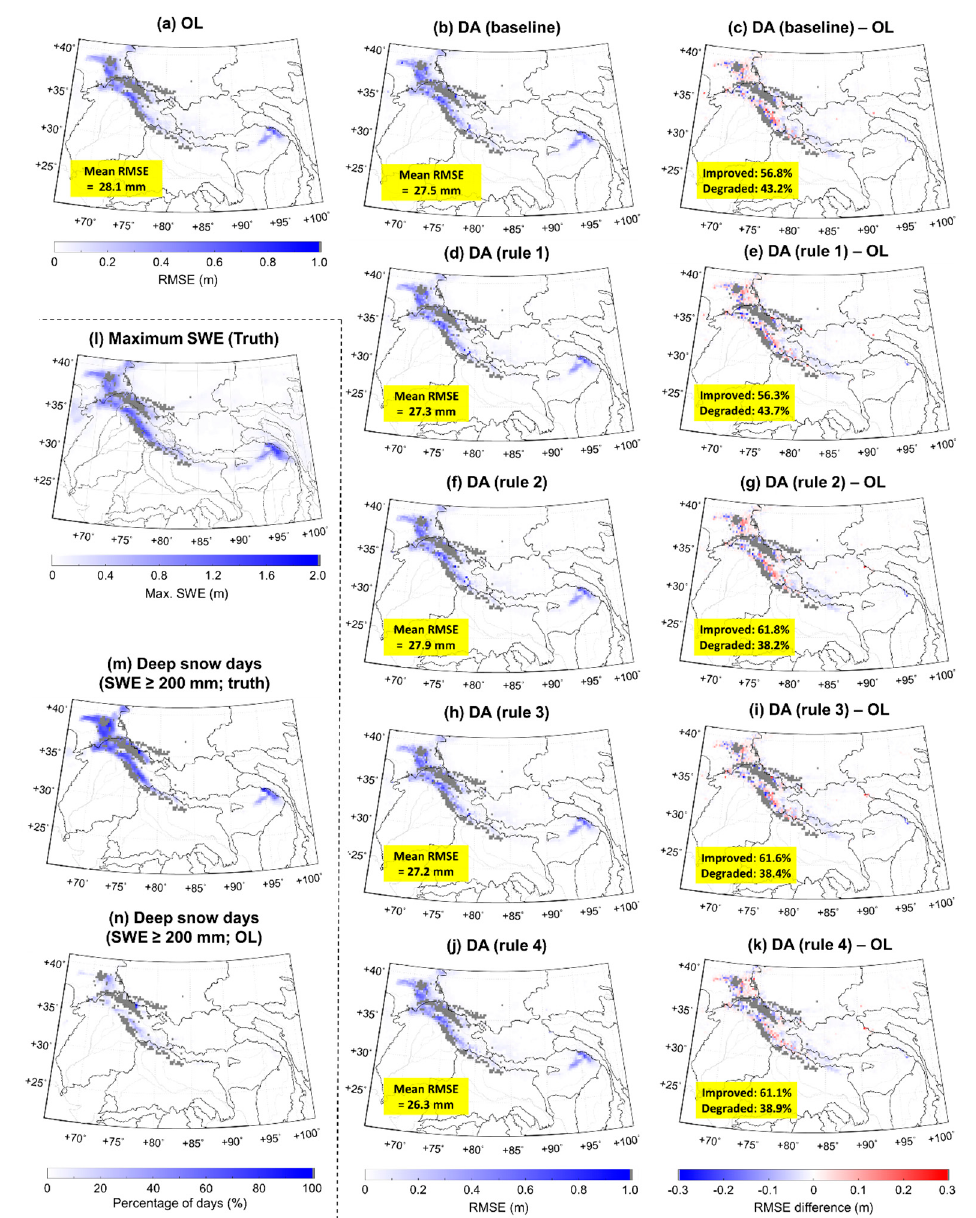
Figure 9. Maps of SWE RMSE for OL and DA cases (left column) and their differences (RMSE DA − RMSE OL ; middle column): ( a ) OL, ( b , c ) DA (baseline), ( d , e ) DA (rule 1), ( f , g ) DA (rule 2), ( h , i ) DA (rule 3), and ( j , k ) DA (rule 4) (see Table 4 for descriptions of the rules applied). Negative (blue color) and positive (red color) RMSE differences represent improvements and degradations in the SWE estimates, respectively, as a result of invoking assimilation. Glaciated regions (gray color) were excluded from the analysis. Maps of the ( l ) maximum SWE in the synthetic truth, ( m ) percentage of deep snow days (SWE ≥ 200 mm) in the synthetic truth, and ( n ) percentage of deep snow days (SWE ≥ 200 mm) in the OL case are presented for reference.